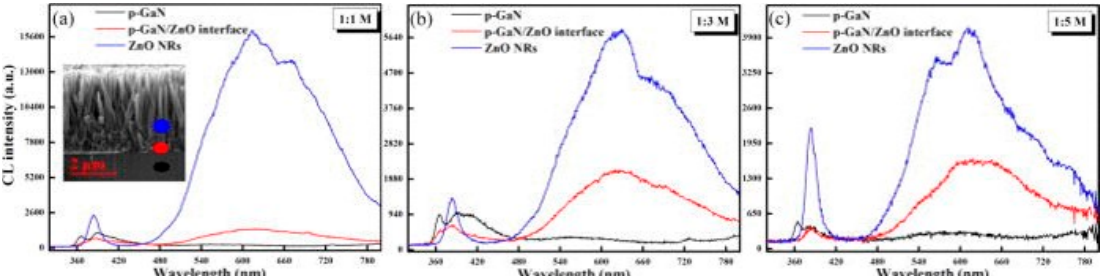
Figure 4. CL spectra of ZnO nanorod junctions with p-type GaN substrates measured in cross-section. ( a ) Inset shows a characteristic cross-sectional SEI of the heterostructure with blue, red, and black (from top to bottom) spots indicating spatial locations within the heterostructure corresponding to the blue, red, and black (from top to bottom) spectra in each of the figures. The 625–670 nm (1.85–2 eV) defect intensities relative to the 375 nm (3.3 eV) NBE peak emission increase from ( a ) 1:1 M to ( b ) 1:3 M to ( c ) 1:5 M. With permission from American Institute of Physics [47].